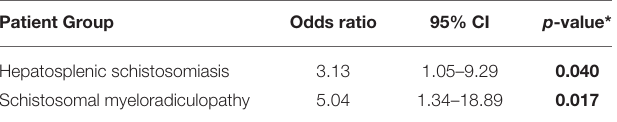
TABLE 3 | Multivariate ordinal regression model for overall quality of life based on the short form of the World Health Organization Quality of Life questionnaire (WHOQOL-BREF) in patients with schistosomiasis compared to non-infected volunteers. Patient Group